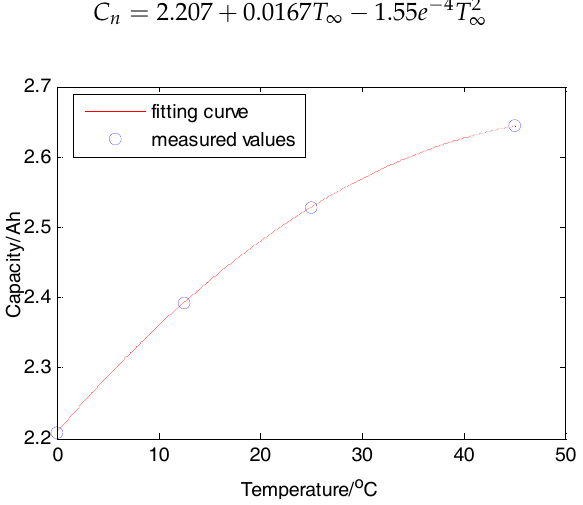
Figure 6. Fitting result of capacity in 0–45 °C.